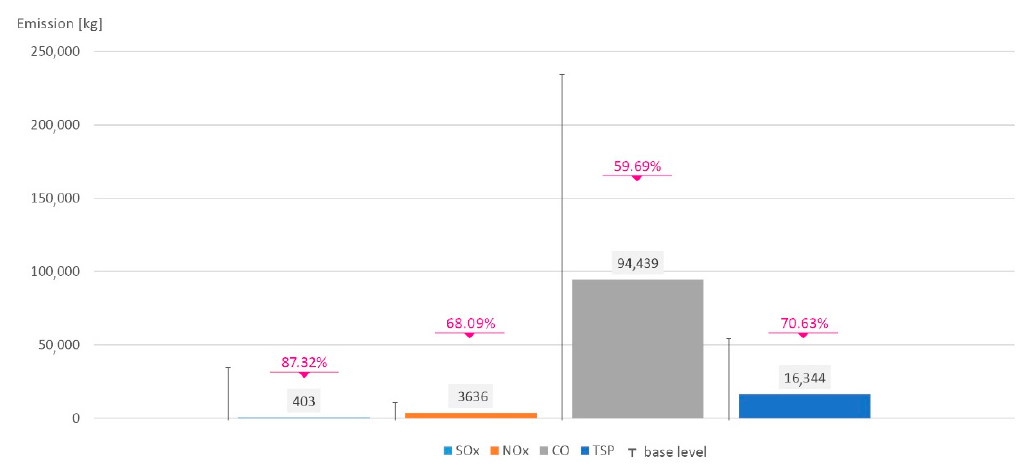
Figure 13. Annual emissions of pollutants in Model 7: 50% biomass, 50% heat pumps.